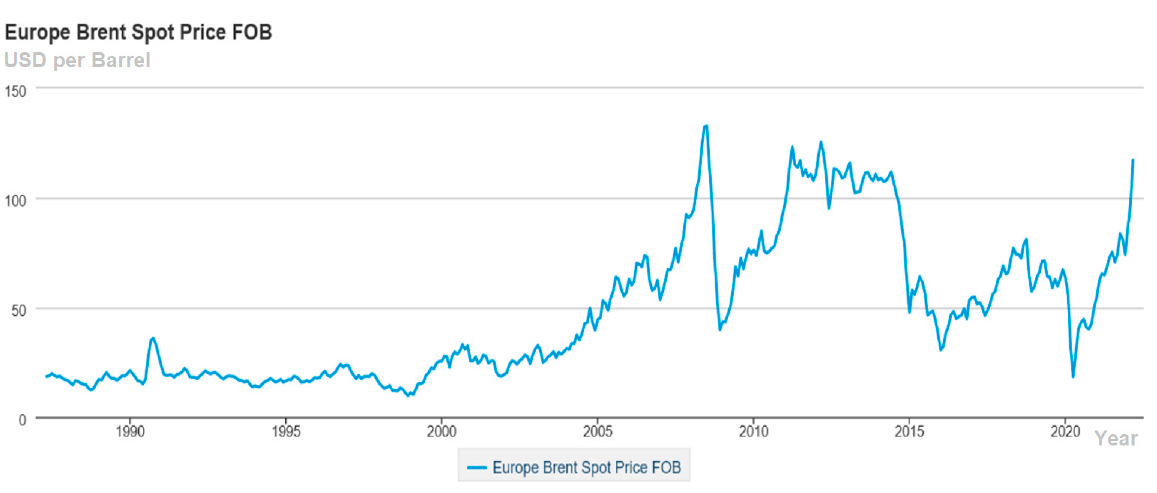
Figure 5. Europe Brent Spot Price—Freight On Board—FOB (USD per Barrel/Year) (source: https://www.eia.gov/dnav/pet/hist/LeafHandler.ashx?n=PET&s=RBRTE&f=M (accessed on 12 November 2022).